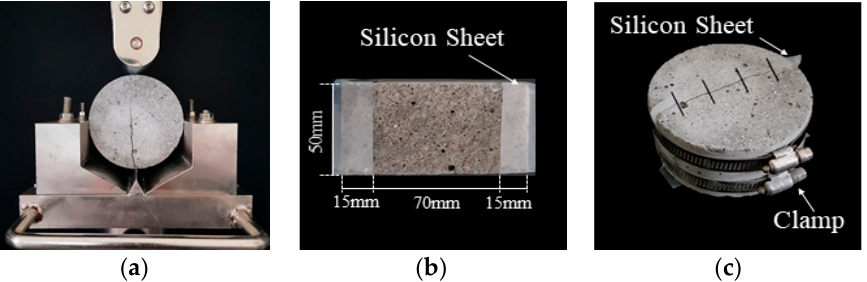
Figure 2. Preparation of cracked specimens: ( a ) split specimen, ( b ) silicon rubber sheets located between semicircular sections, and ( c ) specimen bound together with steel bands.